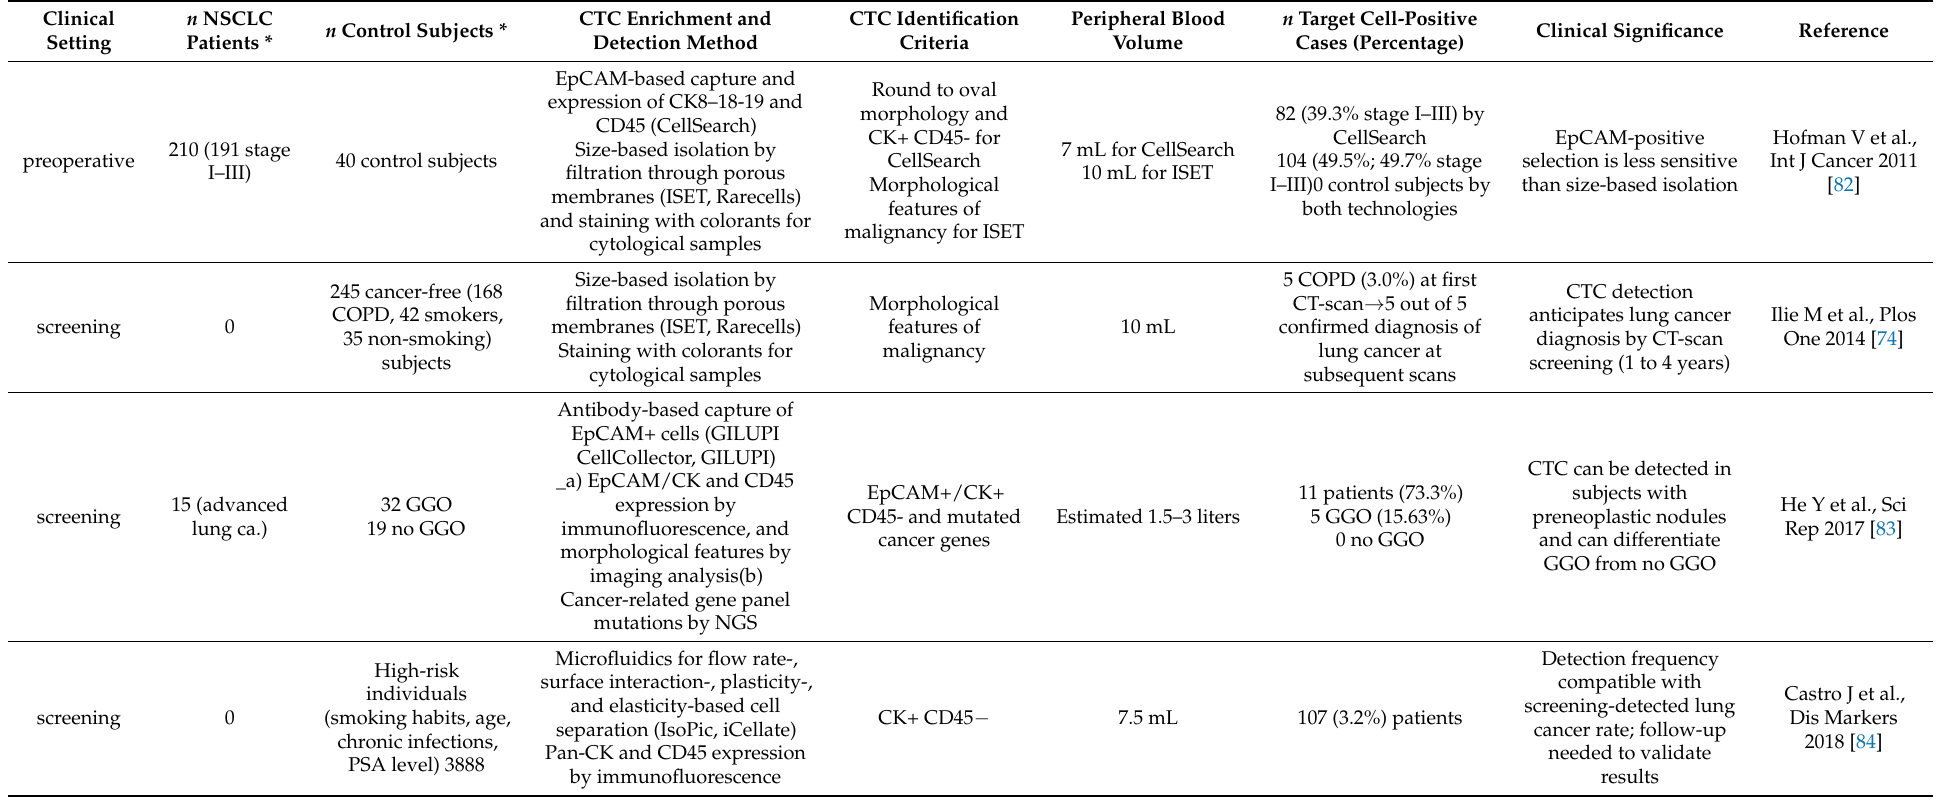
Table 2. Technical performance and clinical significance of circulating tumor cell (CTC) detection in early stage non-small cell lung cancer (NSCLC) patients and in screening programs. Clinical